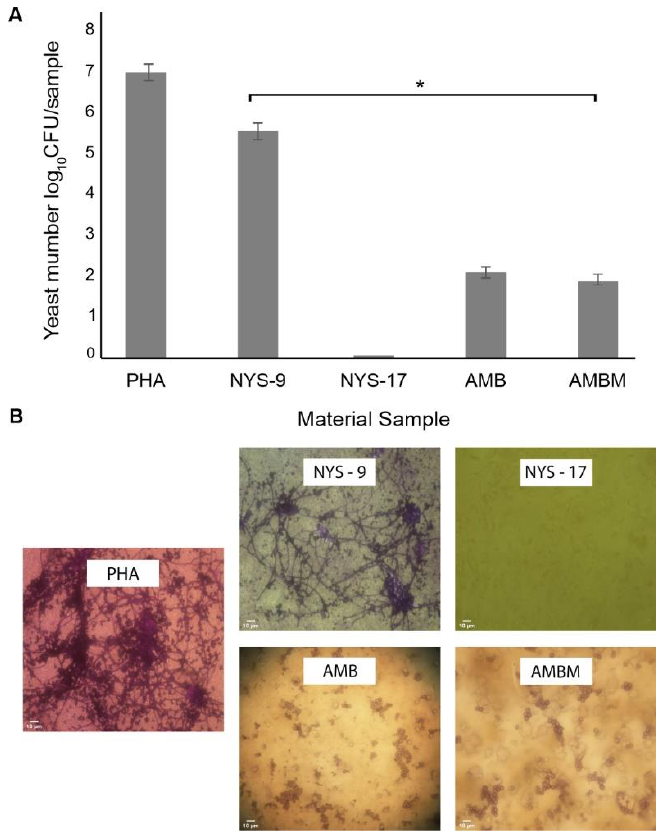
Figure 5. Biofilm formation of Candida albicans 329UCK grown in the presence of mcl-PHA films. ( A ) Adhesion of C. albicans to mcl-PHA films expressed as colony forming units per sample. The data are expressed as the mean ± SD of three separate experiments (* p ≤ 0.05). ( B ) Microscopic images of materials containing C. albicans biofilms. Scale bar,10 µm. NIKON Eclipse 50i (400× mag- nifications).